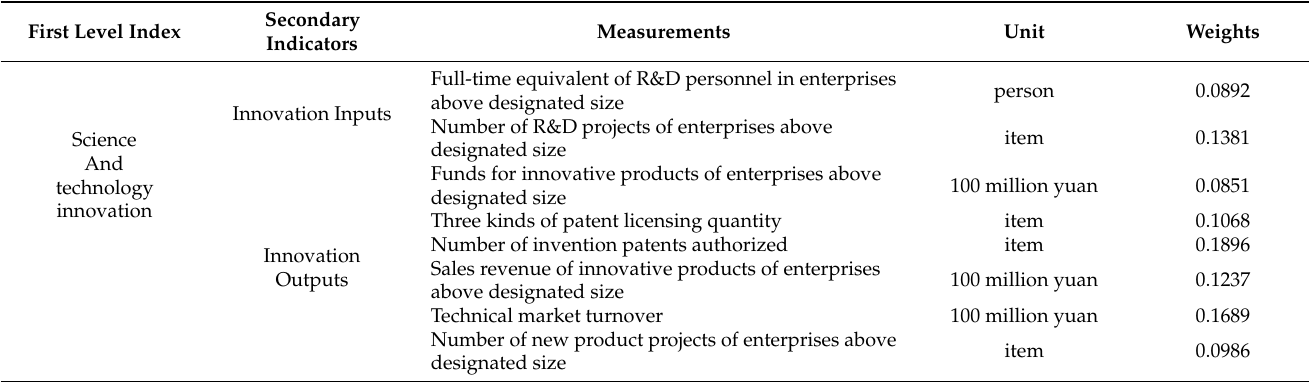
Table 1. Comprehensive evaluation index of technological